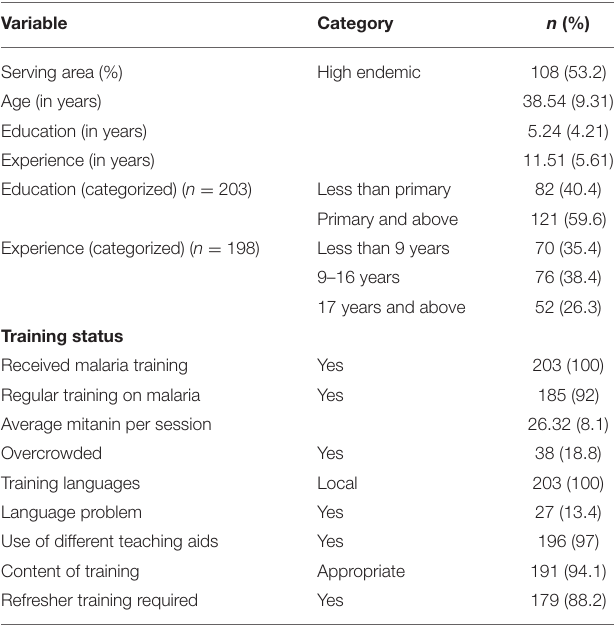
TABLE 1 | Baseline characteristics and training status of the study population ( n = 203).